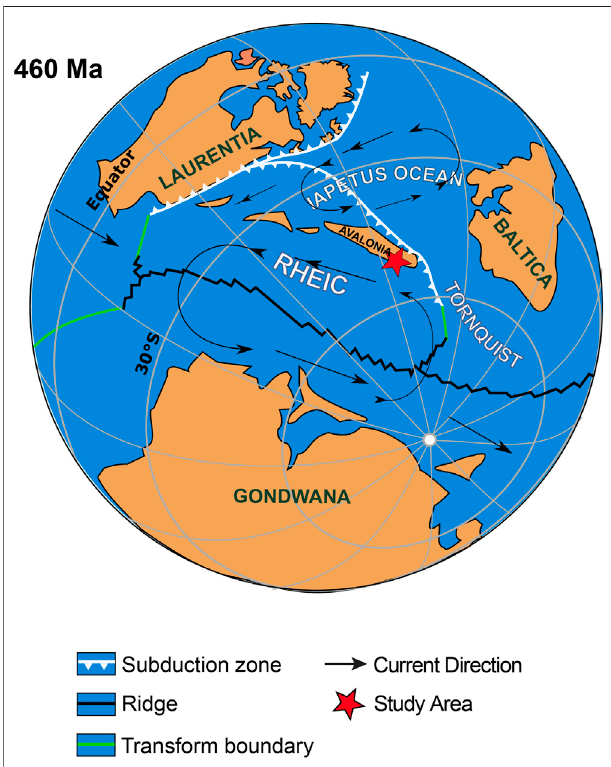
FIGURE11| PaleogeographyoftheMiddleOrdovician.Globaldispersal of continents and major oceans with paleo surface currents (modi fi ed from Torsvik and Cocks, 2013; Pohl et al.,